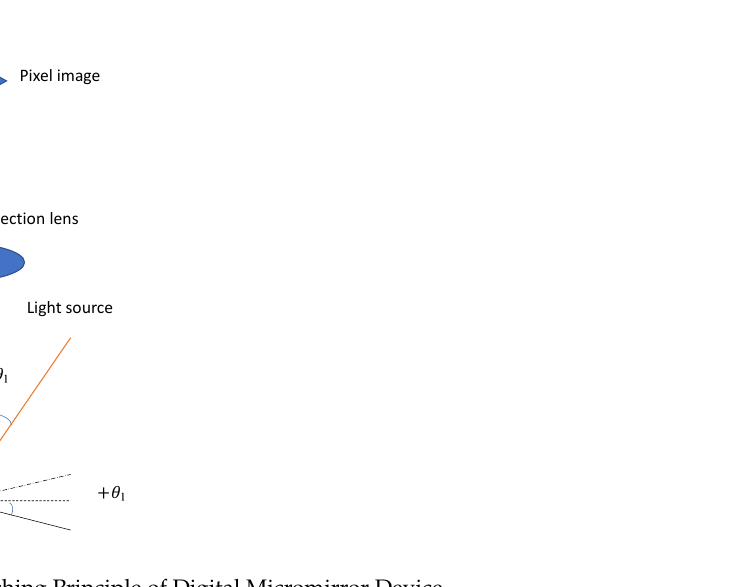
Figure 3. Optical Switching Principle of Digital Micromirror Device.